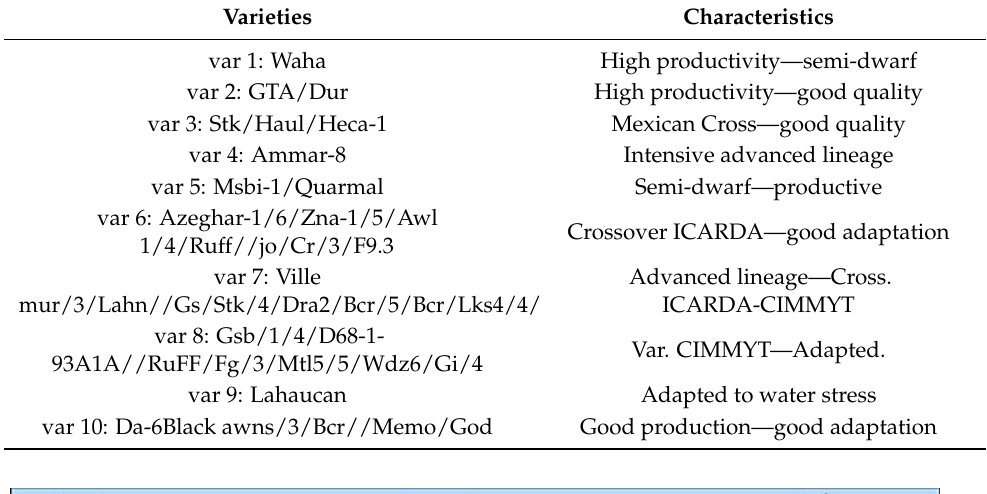
Table 1. Characteristics of the different wheat varieties involved in the study.